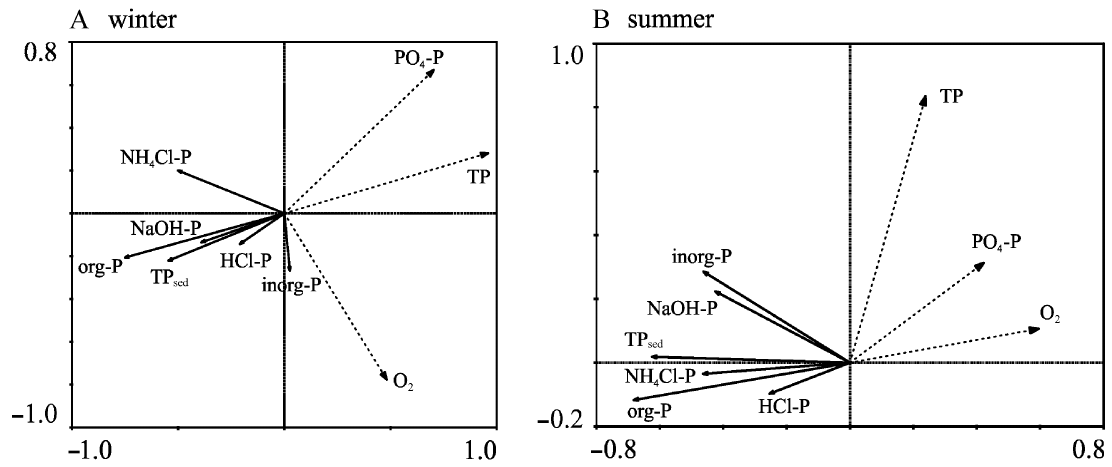
Fig. 3. Redundancy analysis (RDA) biplot constrained to the three measured bottom-water variables (O 2 , PO 4 -P, TP) that explained variances of sediment phosphorus fractions. Biplot A presents winter and B summer